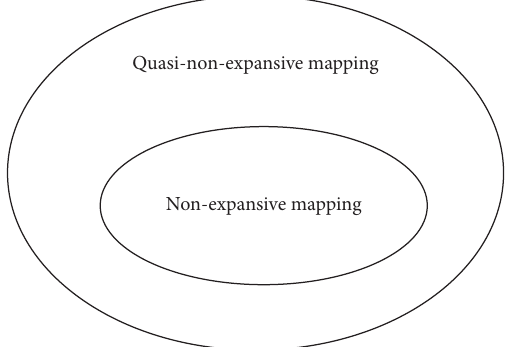
Figure 1: The relations of some nonlinear operators.